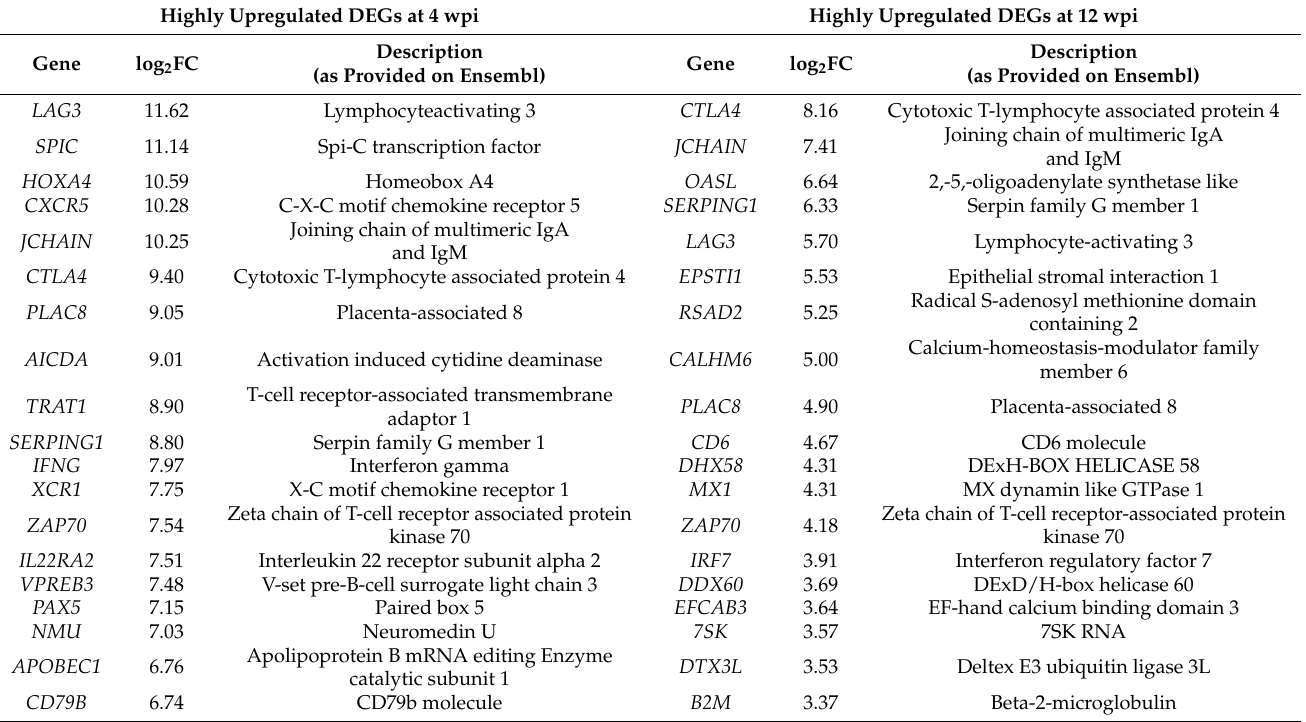
Table 3. Top 20 highly up- and downregulated known DEGs in the brains of ABBV-1-infected Muscovy